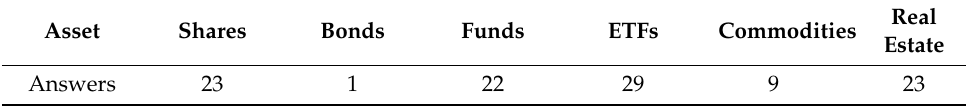
Table 2. The number of votes for each asset by the lower-risk participants.